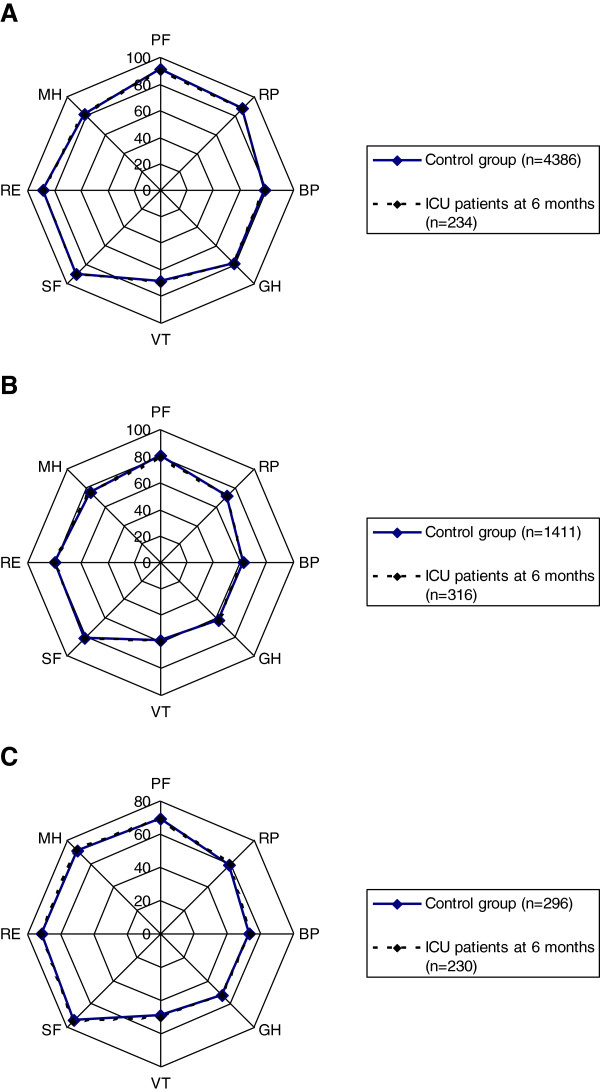
Health-related quality-of-life differences between the reference group and ICU patients without preexisting diseases, with one preexisting disease, and more than one preexisting disease, respectively. (A) Health-related quality of life (SF-36) values shown for each dimension: physical functioning (PF), role limited by physical problems (RP), bodily pain (BP), general health (GH), vitality (VT), social functioning (SF), role limited by emotional problems (RE), and mental health (MH) in the Polar Plot Chart for the healthy reference group (n = 4,386) and the previously healthy ICU patients (n = 234), adjusted for age and sex. (B) Health-related quality of life (SF-36) values shown for each dimension: physical functioning (PF), role limited by physical problems (RP), bodily pain (BP), general health (GH), vitality (VT), social functioning (SF), role limited by emotional problems (RE), and mental health (MH) in the Polar Plot Chart for the reference group (n = 1,411), and the patients from ICU (n = 316) with one preexisting disease, adjusted for age and sex. (C) Health-related quality of life (SF-36) values shown for each dimension: physical functioning (PF), role limited by physical problems (RP), bodily pain (BP), general health (GH), vitality (VT), social functioning (SF), role limited by emotional problems (RE), and mental health (MH) in the Polar Plot Chart for the reference group (n = 296) and the patients from ICU (n = 230) with more than one preexisting disease, adjusted for age and sex.